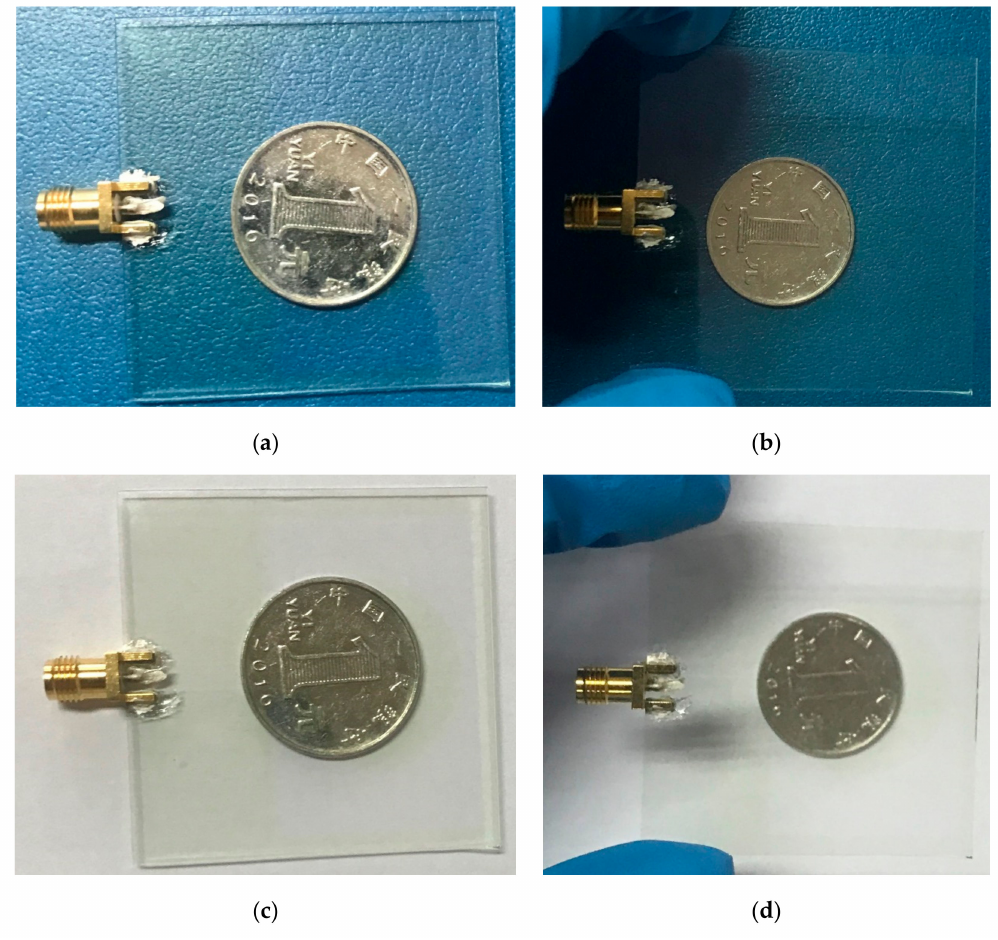
Figure 2. The photograph of the fabricated antenna and the transparency situations when it is ( a ) next to blue paper, ( b ) 20 mm away from blue paper, ( c ) next to white paper, and ( d ) 20 mm away from white paper.